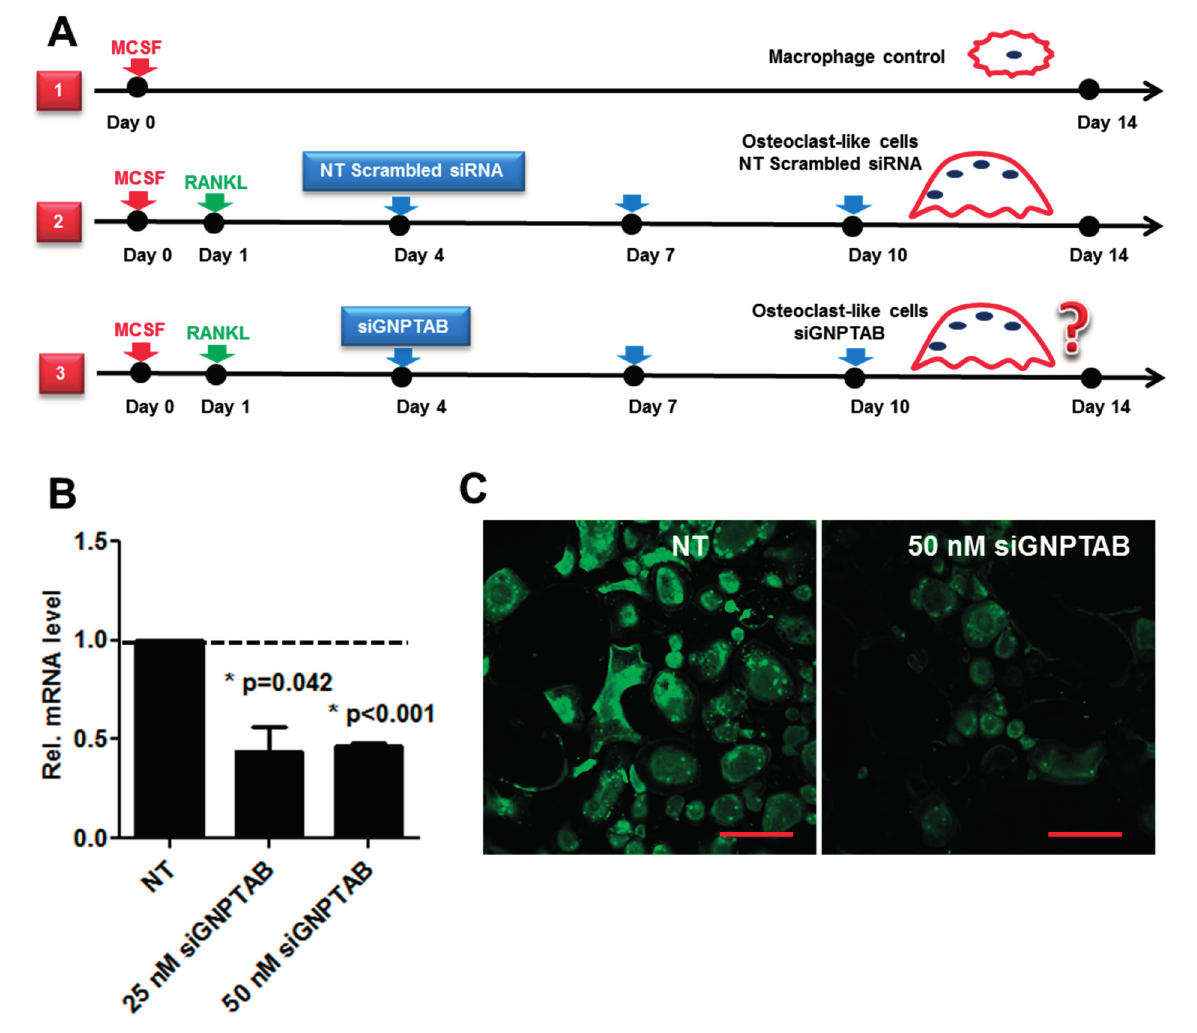
Figure 3. ( A ) Schematic illustrates the treatment protocol for isolated CD14-immunoreactive monocytes. Group 1, control group; group 2, differentiated osteoclasts treated with non-targeting (NT) scrambled control siRNA; and group 3, differentiated osteoclasts treated with siRNA GNPTAB; ( B , C ) Silencing efficiency was determined at both mRNA and protein levels by immunofluorescence. Bars = 200 µm ( n = 4; two technical replicates